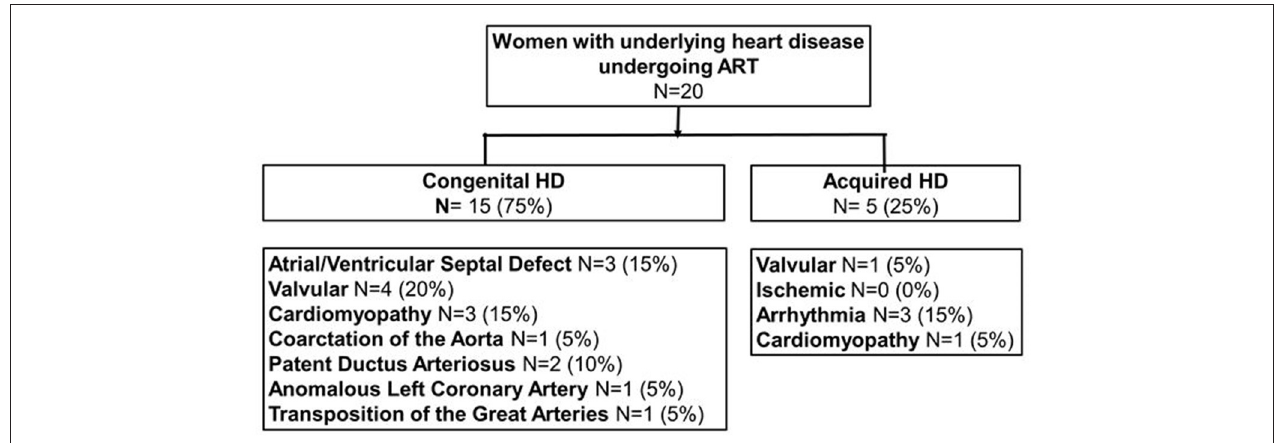
TABLE 2 | Cardiovascular and ART complications of women with HD and controls.